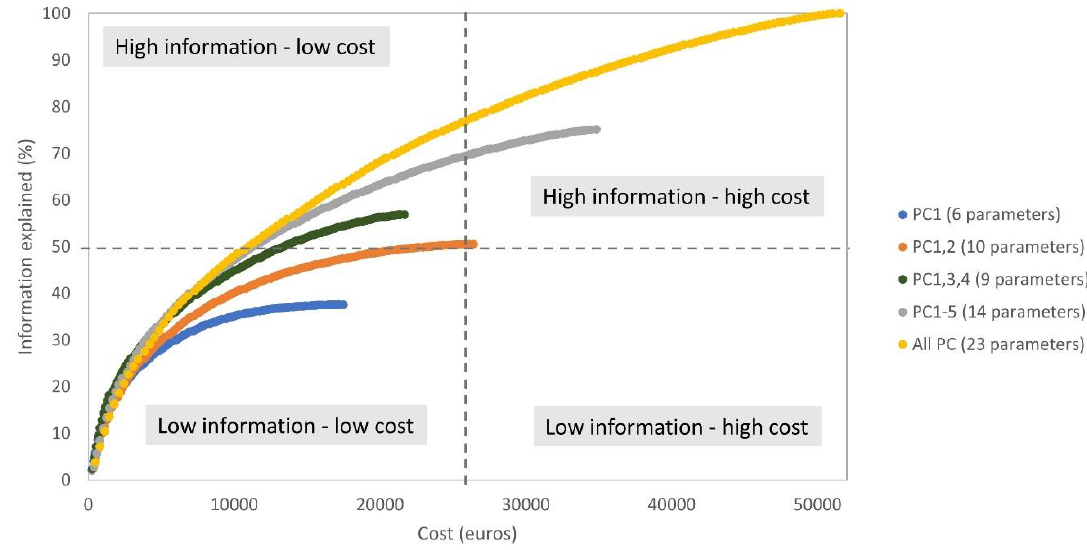
Figure 6. The cost-information plane for different monitoring strategies. PC1 (37.6%)—monitoring 6 water quality variables at one to 151 sites, PC1,2 (50.5%)—monitoring 10 variables at one to 151 sites, PC1,3,4—monitoring 9 variables at one to 151 sites, PC1-5 (75.1%)—monitoring 14 variables at one to 151 sites, and All PC (100%)—monitoring 23 variables at one to 151 sites.